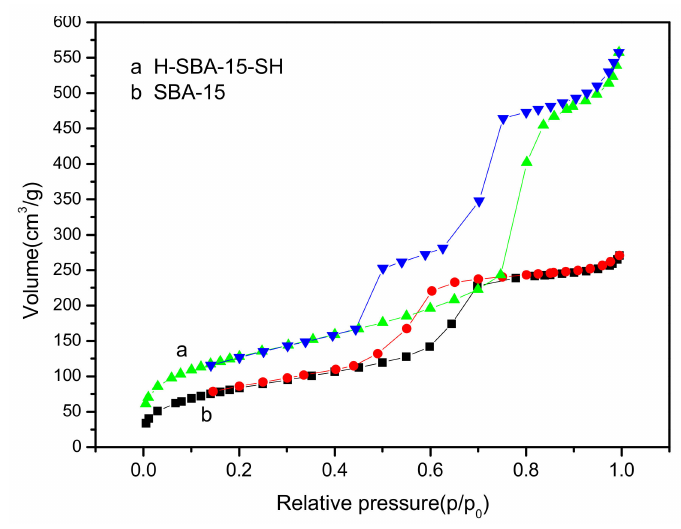
Figure 4. N 2 adsorption isotherms of mesoporous SBA-15 and H-SBA-15-SH.